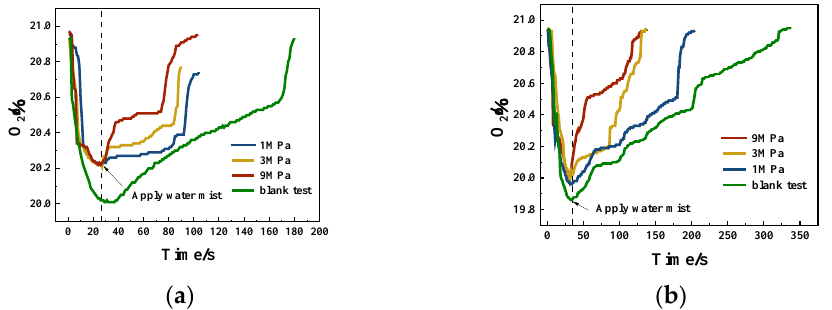
Figure 9. Change curve of O 2 concentration under different pressures: ( a ) materials are placed horizontally, ( b ) materials are placed vertically.